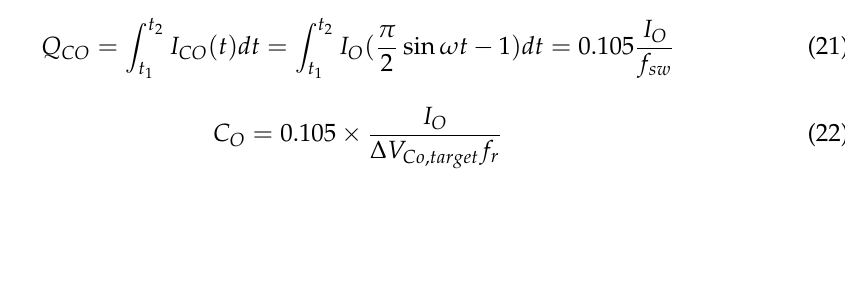
Figure 14. Current waveform of the output capacitor. 6. Four Representative Sag Types of V leg According to the Carrier Deformation For stable operation of the MNRV DPWM-based full-bridge diode-clamped multi- level resonant converter as described thus far, an appropriate carrier design is required. In DC/DC converters, it is important to maintain the symmetry of the voltage applied to the transformer. In order to maintain the symmetry of V leg , which is the resonant tank in- put voltage, the carrier counting direction and initial value must be set appropriately ac- cording to CM. Figure 15 shows the representative V leg that can be implemented according to the carrier deformation. V leg basically takes the shape of a square wave for maximum power transfer. Additionally, at the middle, edge, or rear of the waveform, taking the form of a stepped sag, i.e., V dc → 2/3 × V dc → 1/3 × V dc → 2/3 × V dc → V dc , V leg decreases and increases